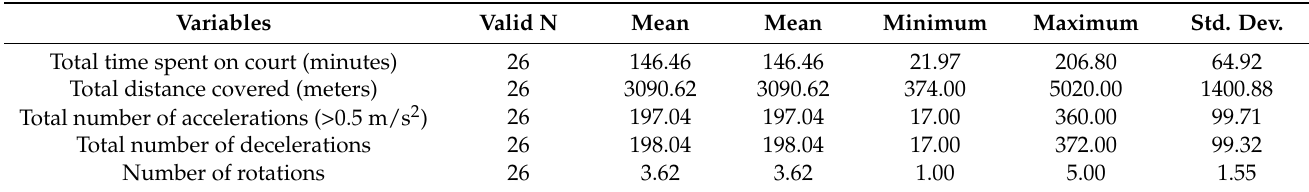
Table 4. Total workload per